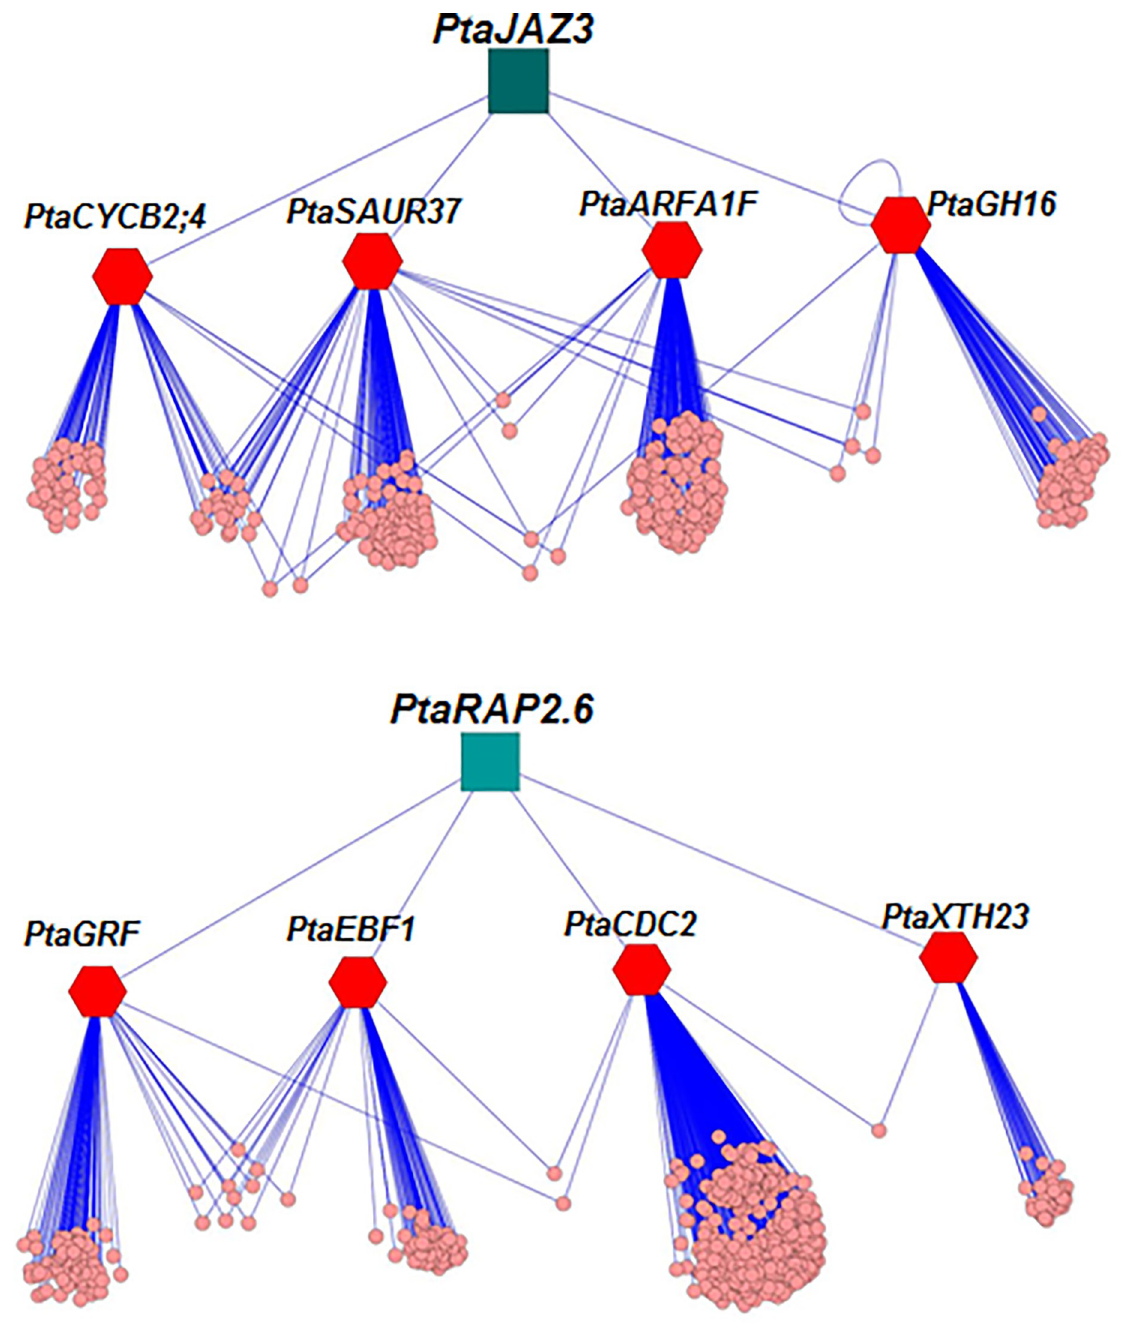
Fig 4. PtaJAZ3 -and PtaRAP2 . 6- centered networks. Both the regulatory networkswere generated using Algorithm for the Reconstruction of Accurate Cellular Networks (ARACNE) analysis (see experimental procedures).The two superhubs (squares) were connected to four hub genes (hexagons) which in turn were connected to terminal genes (circles). Abbreviations for the four hubs connected to PtaJAZ3 are as follows: 1. PtaCYCB2;4 (Cycline B2;4, Potri.005G251400); 2. PtaSAUR37 (SmallAuxin Upregulated RNA 37, Potri.006G278100); 3. PtaARFA1F (ADP-Ribosylation Factor A1F, Potri.008G100000); 4. PtaGH16 (Glycosyl Hydrolases family 16, Potri.006G071200). Abbreviations for the four hubs connected to PtaRAP2 . 6 are as follows: 1. PtaGRF (Gibberellin-Regulated Family protein,Potri.014G020100); 2. PtaEBF1 (EIN3-Binding F- box protein1, Potri.006G068500); 3. PtaCDC2 (Cell Division Control 2, Potri.004G133500); 4. PtaXTH23 (Xyloglucan Endotransglucosylase/ Hydrolase 23, Potri.018G095100). Details of the terminal genes connected to individual hubs are provided in S4 Data and S1 Table.